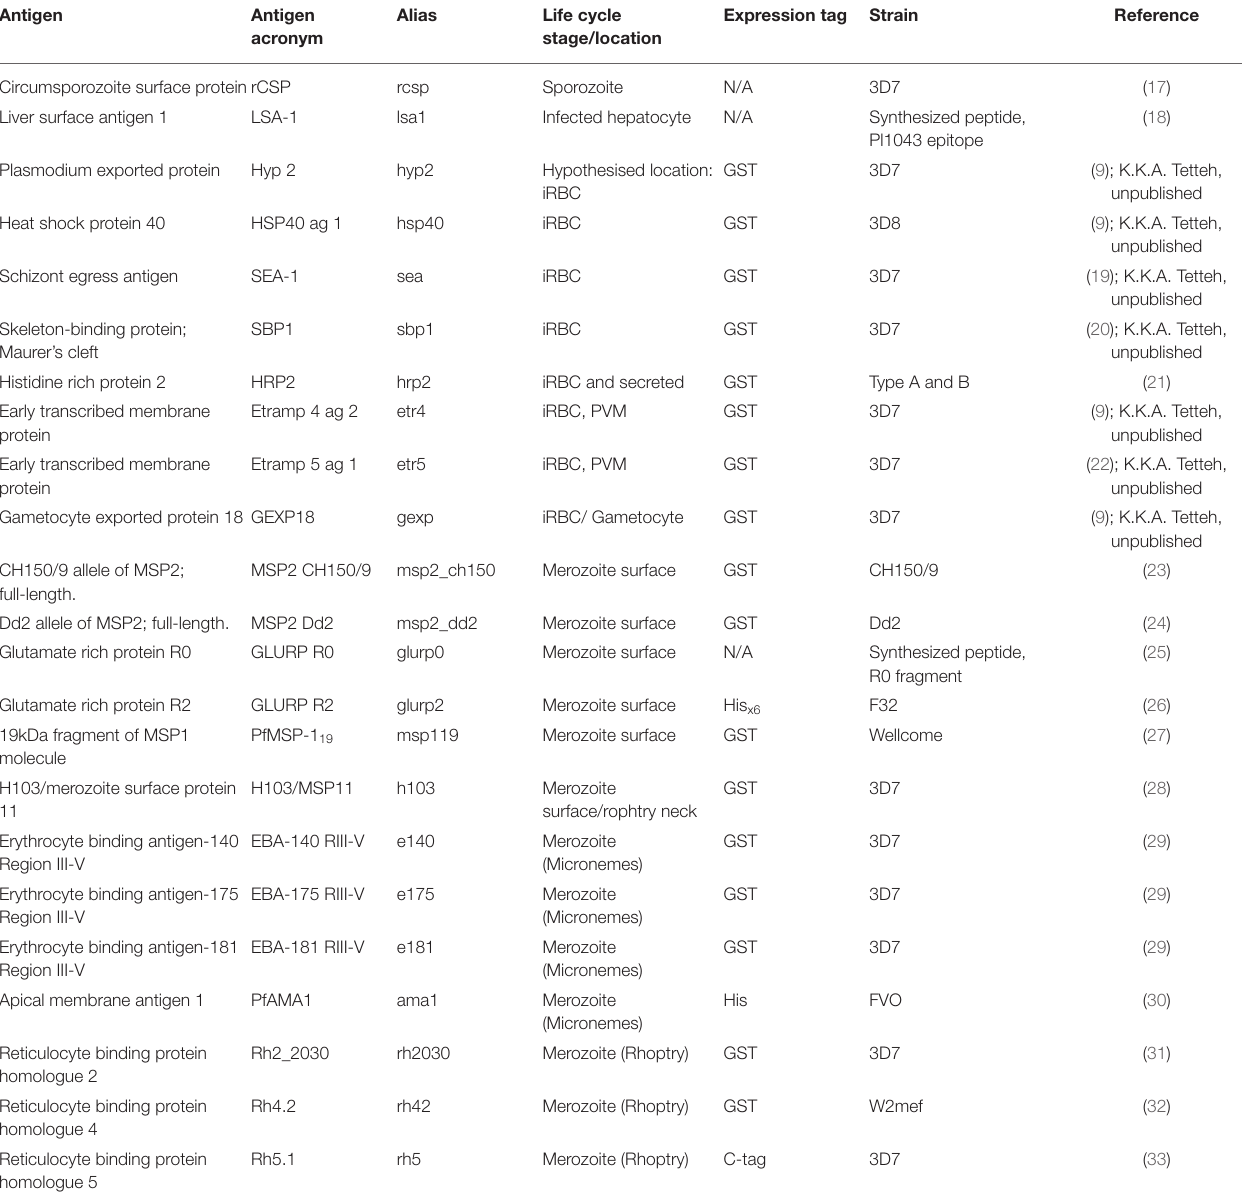
TABLE 2 | Characteristics of multiplex bead assay Plasmodium falciparum antigen panel. Antigen Antigen Alias Life cycle Expression tag Strain acronym stage/location